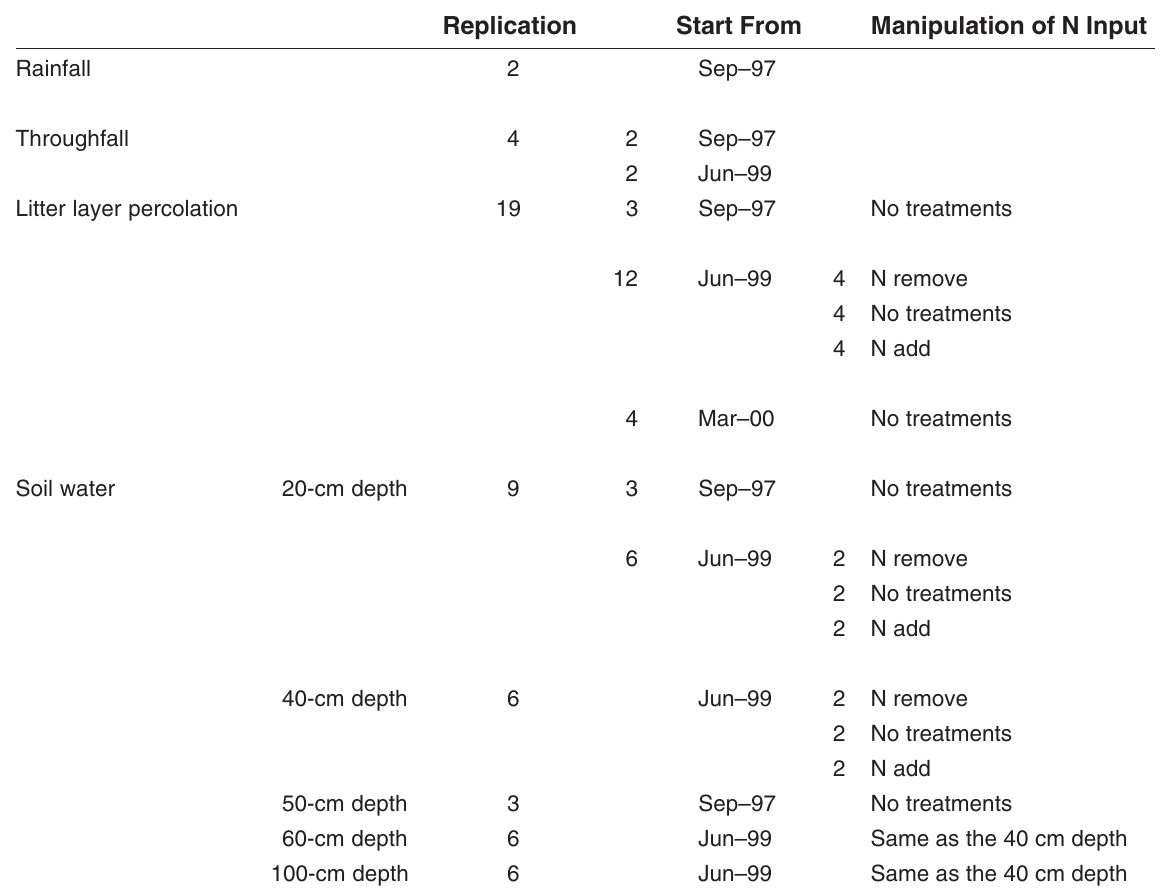
Overview of the Field Measurements and N Input Manipulation Experiment in Each Stand Replication Start From Manipulation of N Input Rainfall 2 Sep–97 Throughfall